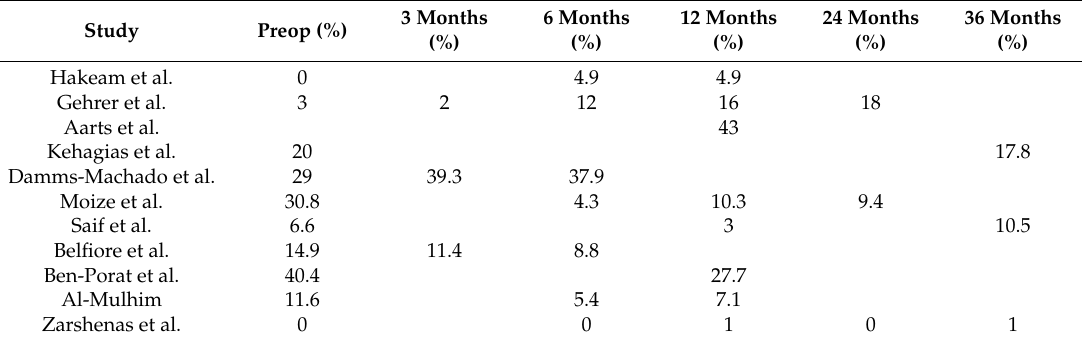
Table 2. Iron (%): Percentage (%) of patients with deficiencies at each postoperative